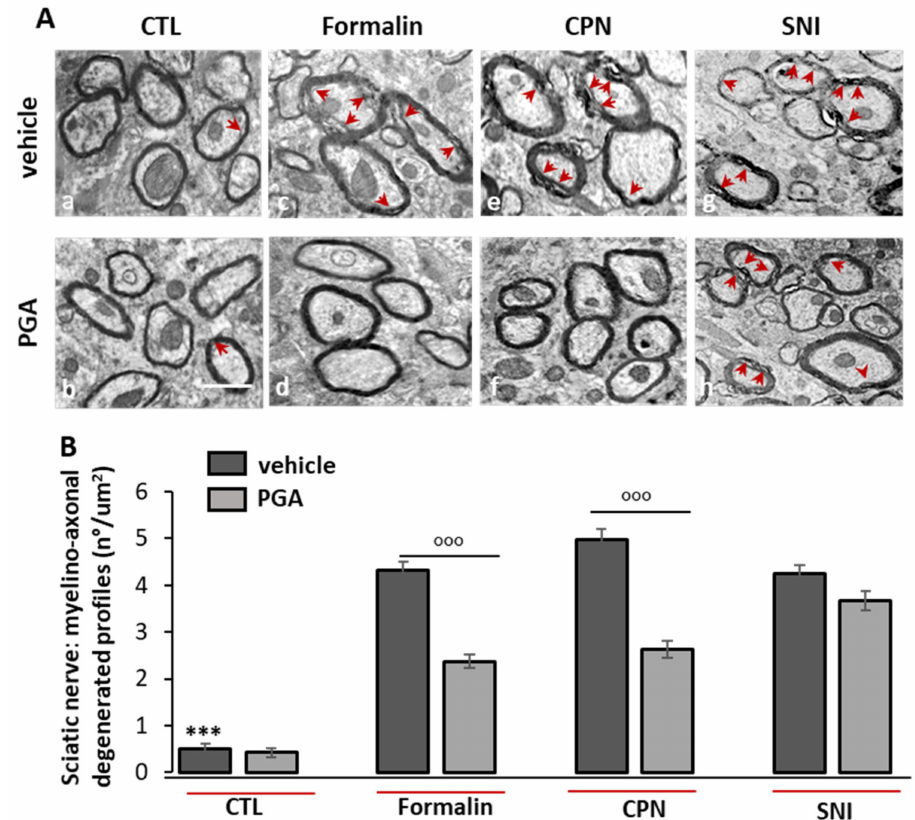
Figure 6. PGA (5–20 mg/kg o.s.) reinstated the ultrastructural changes of the impaired sciatic nerve in neuropathic mice. ( A ) Representative ultrastructural images of the myelin sheath showed that compared with control (a and b), PGA treatment restored the injured structure of sciatic nerve in formalin (c and d)- or CPN (e and f)-induced neuropathic mice, but not in SNI (g and h) mice, in which the myelin layers were damaged and detached from each other. Impaired fibers of sciatic nerve were indicated by red arrows [Scale bar: 1 µ m]. ( B ) Bar graph showing the mean number of injured fibers for each treatment. Measure was expressed as means ± SEM of the number of myelino-axonal degenerated fibers/3micron 2 . One-way ANOVA followed Kruskal-Wallis test plus Dunn’s multiple comparison test was applied. *** p < 0.0001 is referred to vehicle + formalin or vehicle + CPN or vehicle + SNI. ◦◦◦ p < 0.0001 is referred to PGA-treated formalin or CPN